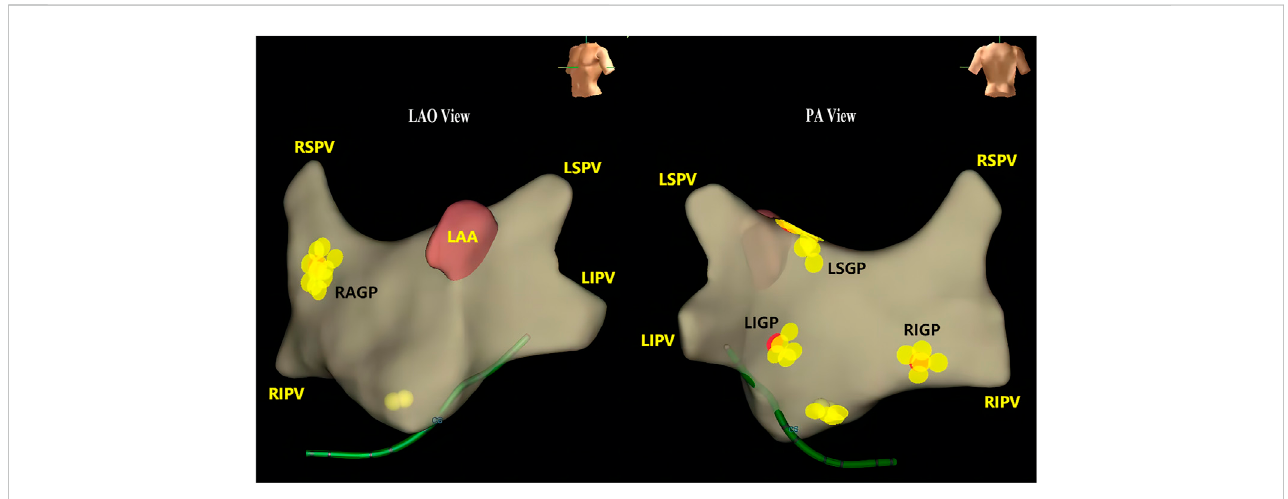
FIGURE 2 Location of the cardiac ganglionic plexus. Three-dimensional endocardial surface of the left atrium and locations of the ganglionated plexi (GPs) of a patient with vasovagal syncope. Yellow points indicate the locations of the GPs. Red points indicate the ablation sites. LAA, left atrial appendage; LIGP, left inferior ganglionated plexus; LIPV, left inferior pulmonary vein; LSGP, left superior ganglionated plexus; LSPV, left superior pulmonary vein; RAGP, right anterior ganglionated plexus; RIGP, right inferior ganglionated plexus; RIPV, right inferior pulmonary vein; RSPV, right superior pulmonary